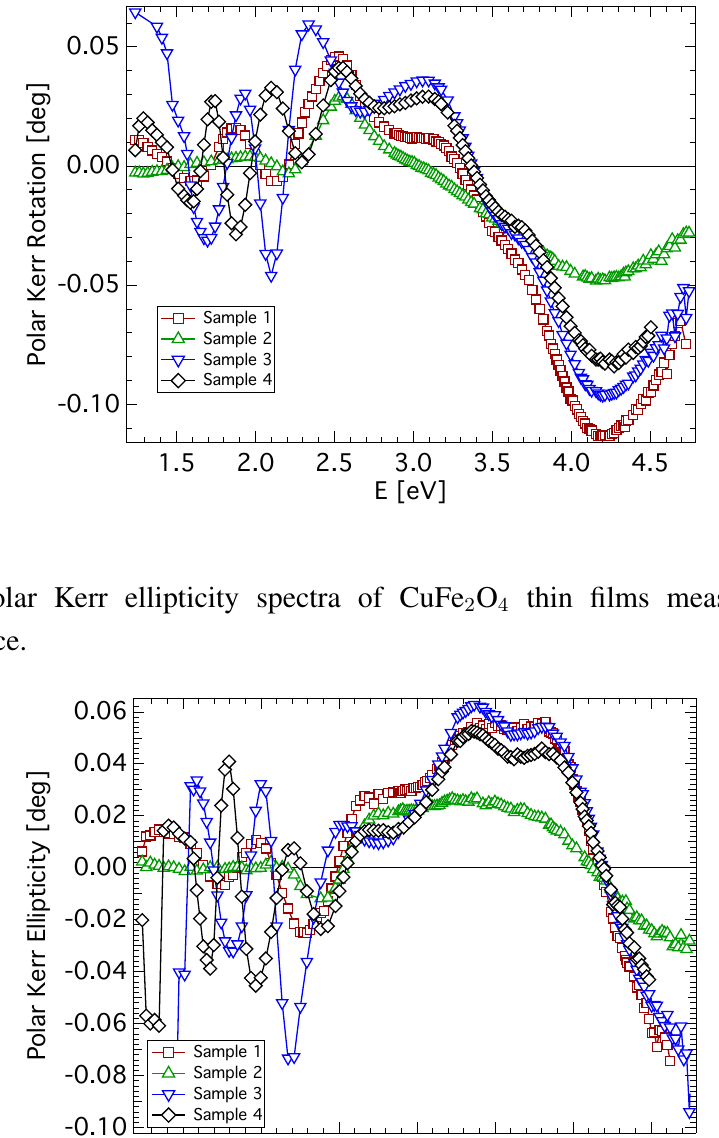
Figure 2. Polar Kerr rotation spectra of CuFe normal incidence.